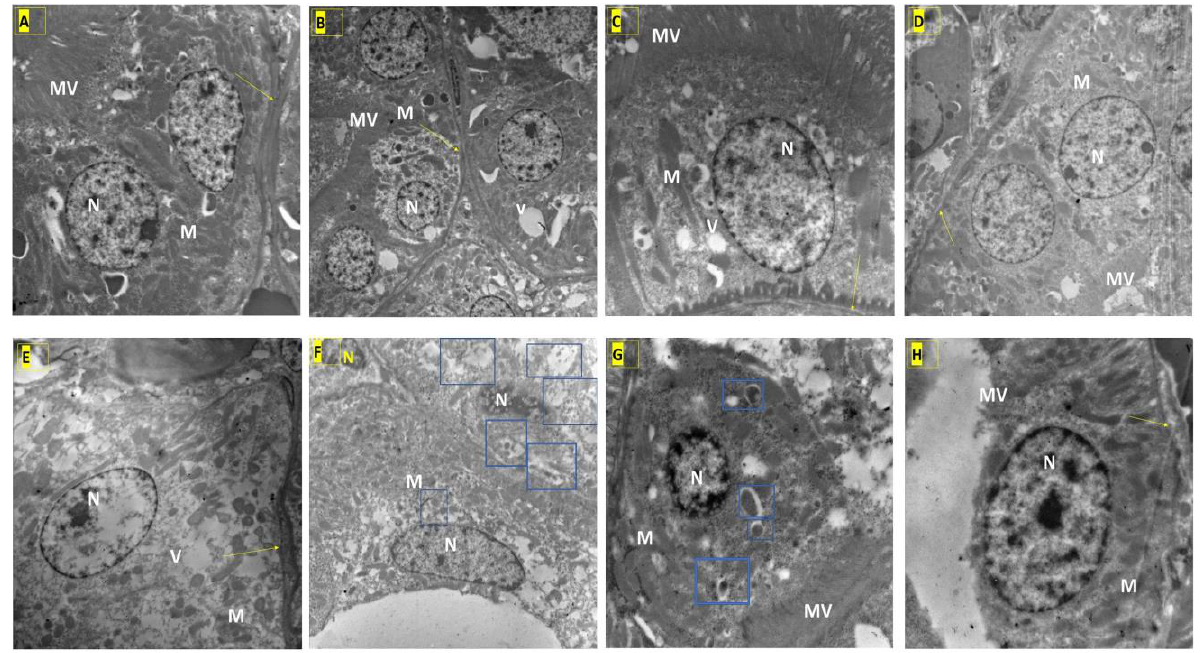
Fig. 5. Ultra structure of renal tubular cells by Transmission Electron Microscopy A: Control group; B: Negative control treated with sitagliptin; C: Negative control treated with oleuropein; D: Negative control treated with combination of sitagliptin and oleuropein, all show renal tubular cells which are exhibiting long abundant apical microvilli (MV), elongated profuse mitochondria (M), euchromatic nuclei (N), intact basal membrane (arrow), and minimal cytoplasmic vacuolation (V); E : In the cisplatin treated rats, the cytoplasm is vacuolated (V), mitochondria are shredded or with